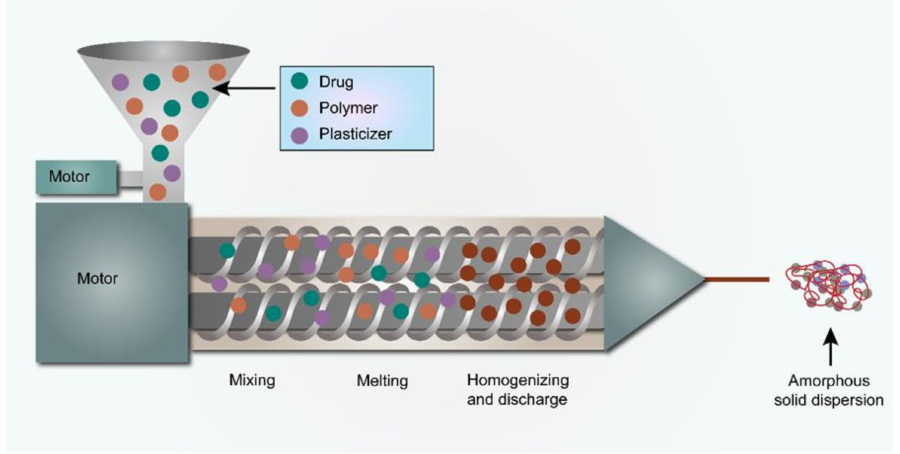
Figure 1. The schematic representation of the HME